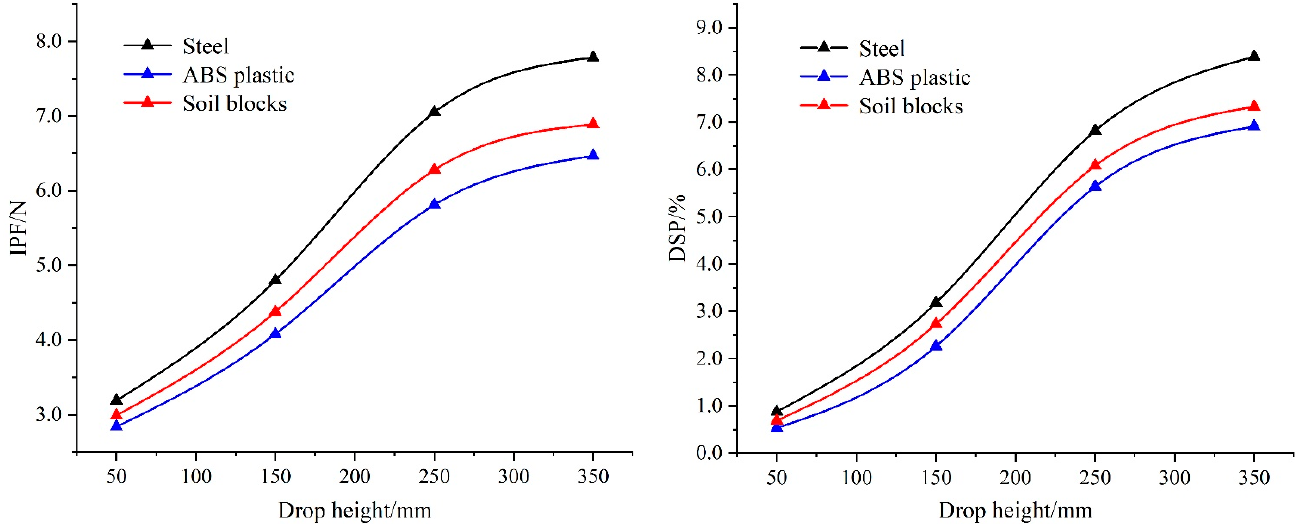
Figure 6. Effect of collision materials and drop heights on IPF and DSP.